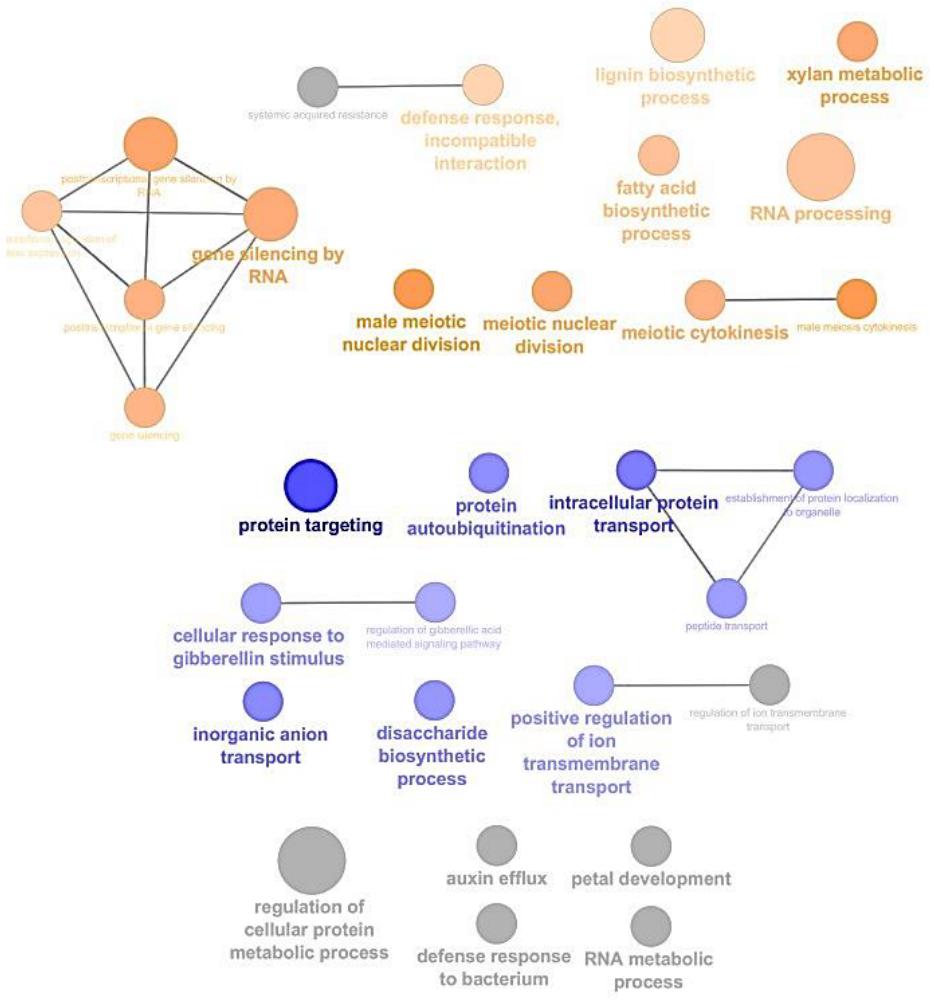
Figure 1. Gene ontology (GO) enrichment performed with the subset of genes showing –2 > fold change > 2 in Cytoscape using ClueGO and CluePedia. Biological processes with genes overrepresented in 21 dai galls and uninfected roots are shown in orange and blue, respectively. All GO are listed in Table S3.